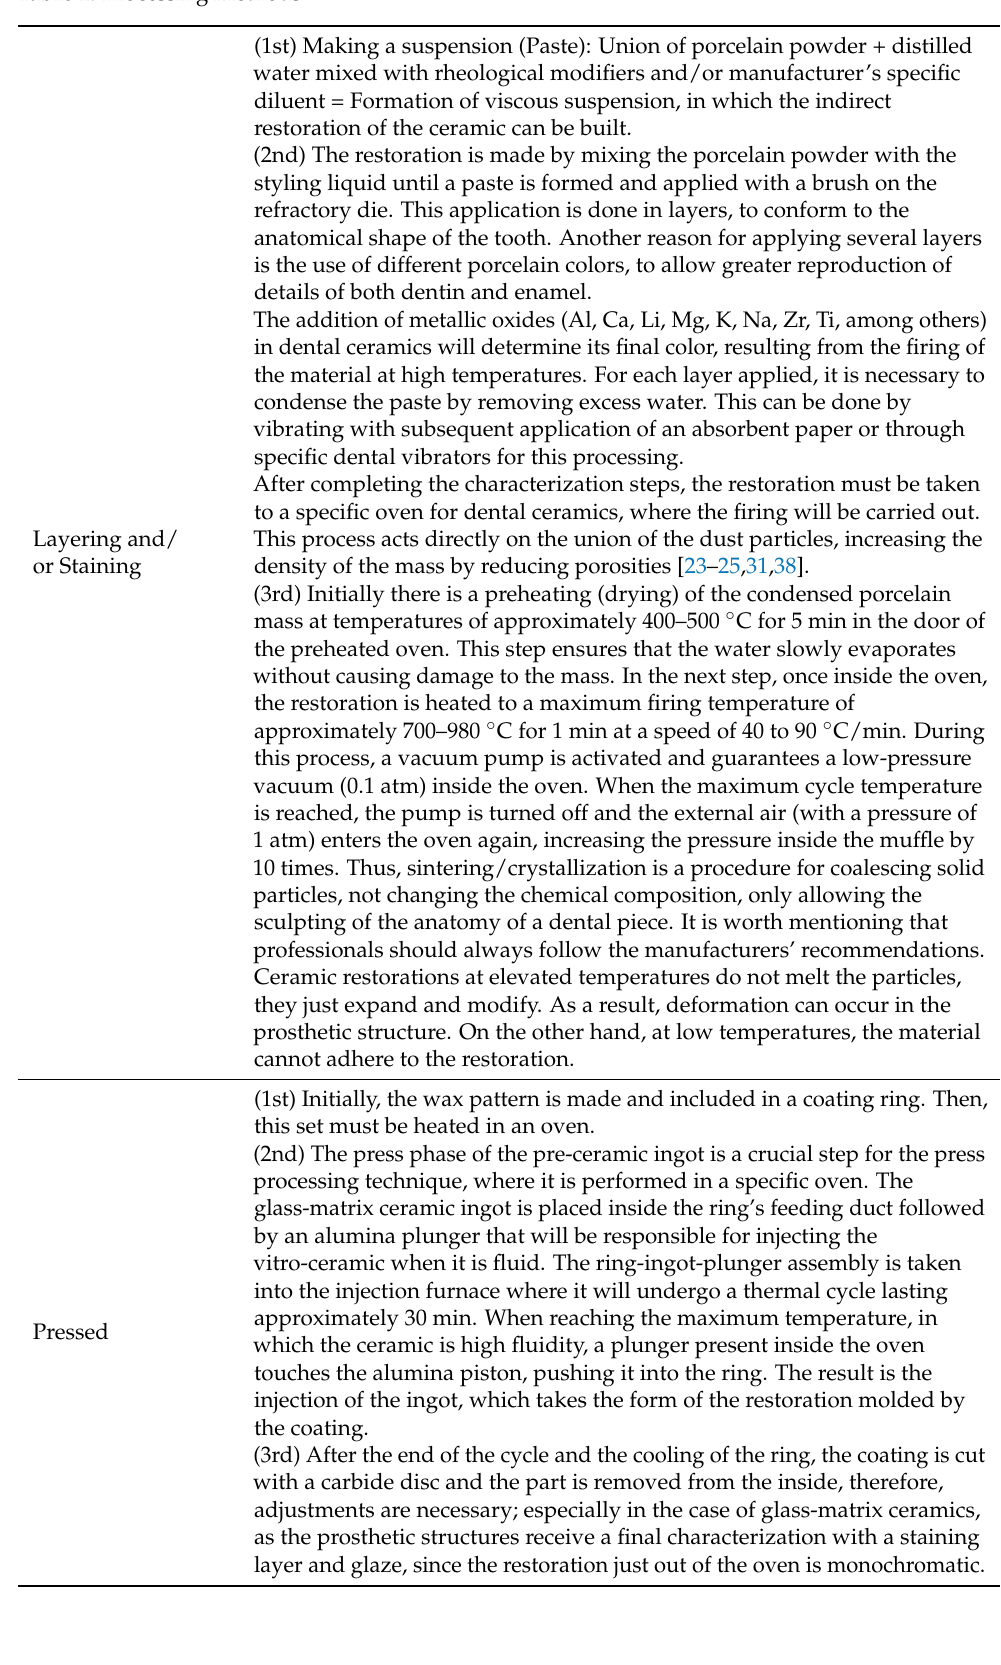
Table 1. Processing